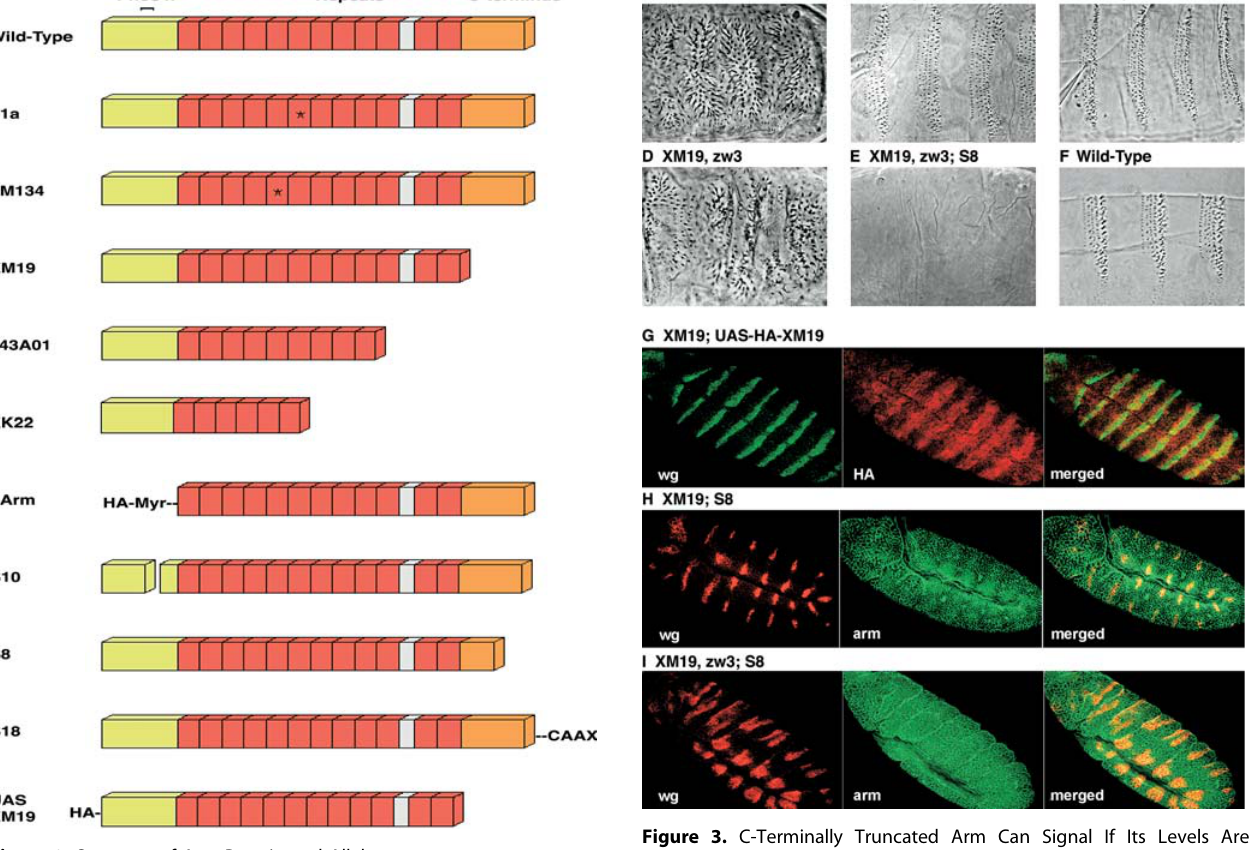
Figure 2. Structure of Arm Protein and Alleles